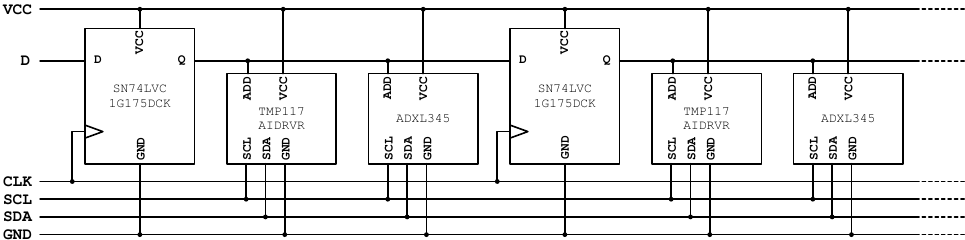
Figure 2. Schematic of cascaded temperature sensors and accelerometers in a shift register configuration Device Integration and Power